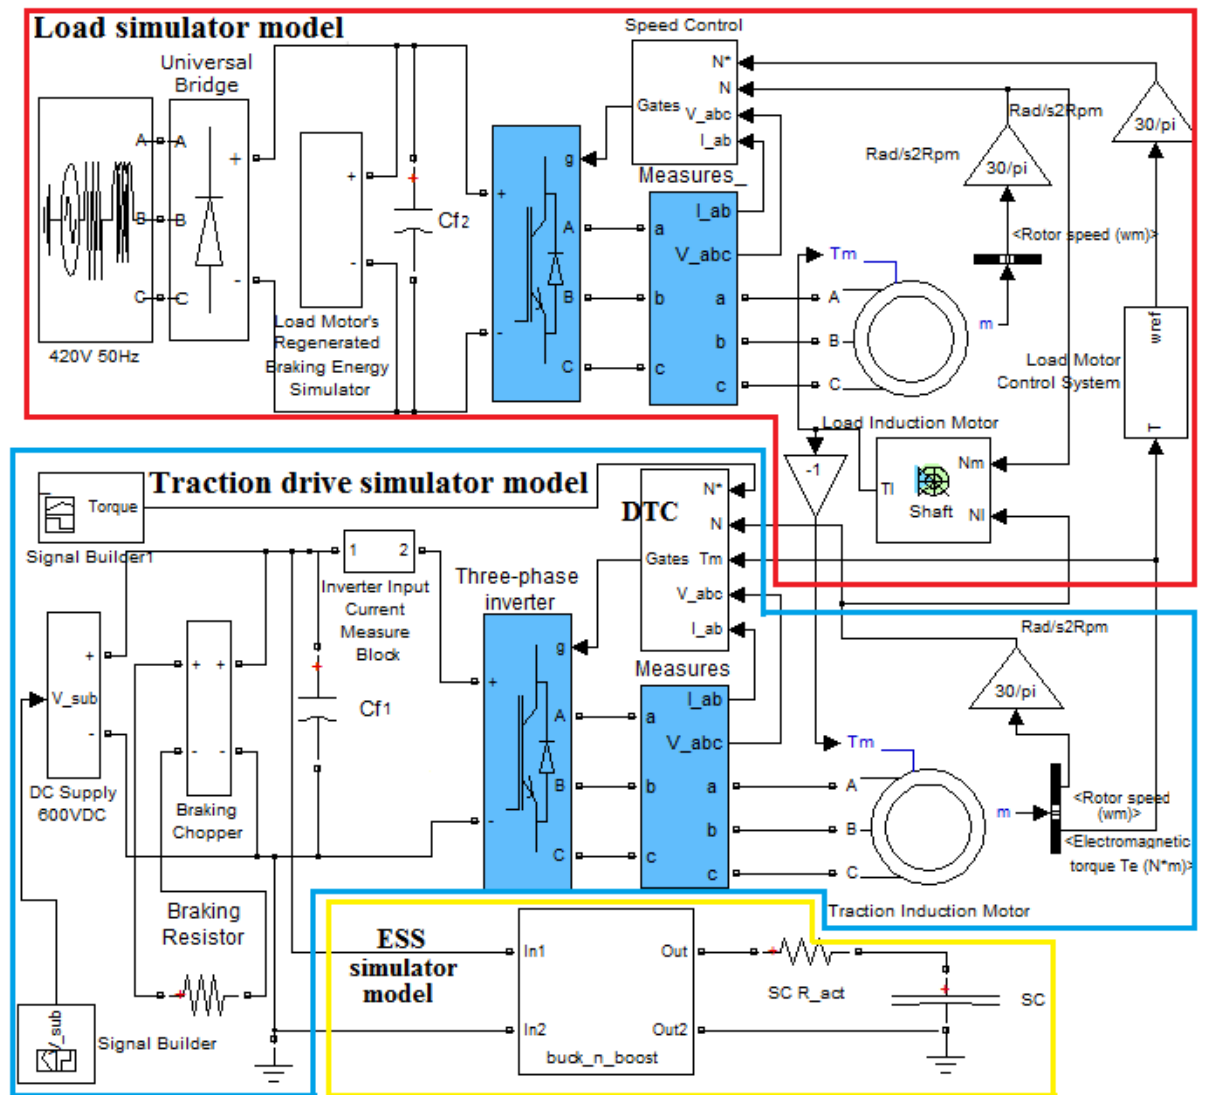
Fig. 3. Matlab/Simulink model of the traction drive test